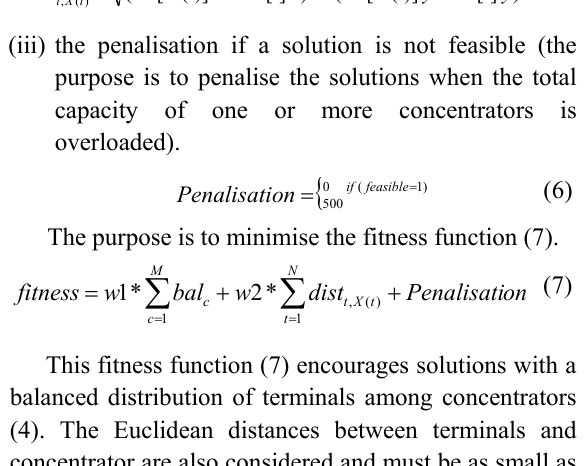
Fig. 2. Reciprocal